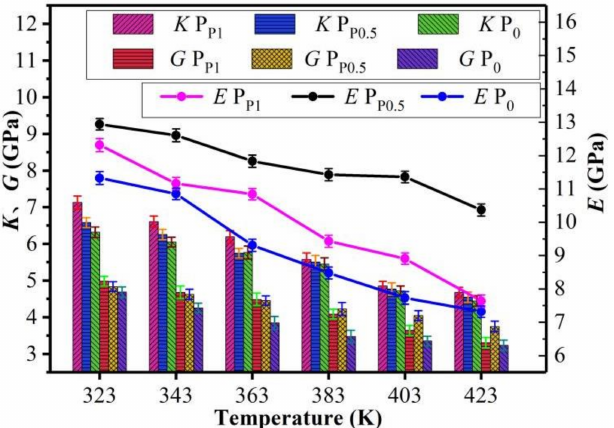
Figure 8. Mechanical parameters of three